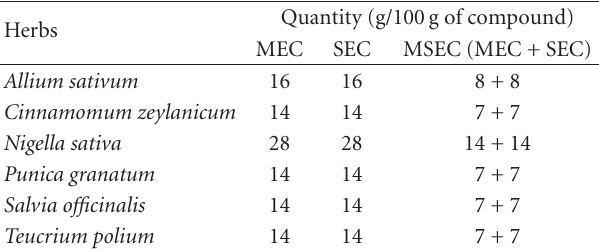
Table 1: Composition of polyherbal compounds. Quantity (g/100g of compound) Herbs MEC SEC MSEC (MEC + SEC) Allium sativum 16 16 8 + 8 Cinnamomum zeylanicum 14 14 7 + 7 Nigella sativa 28 28 14 + 14 Punica granatum 14 14 7 + 7 Salvia o ffi cinalis 14 14 7 + 7 Teucrium polium 14 14 7 + 7